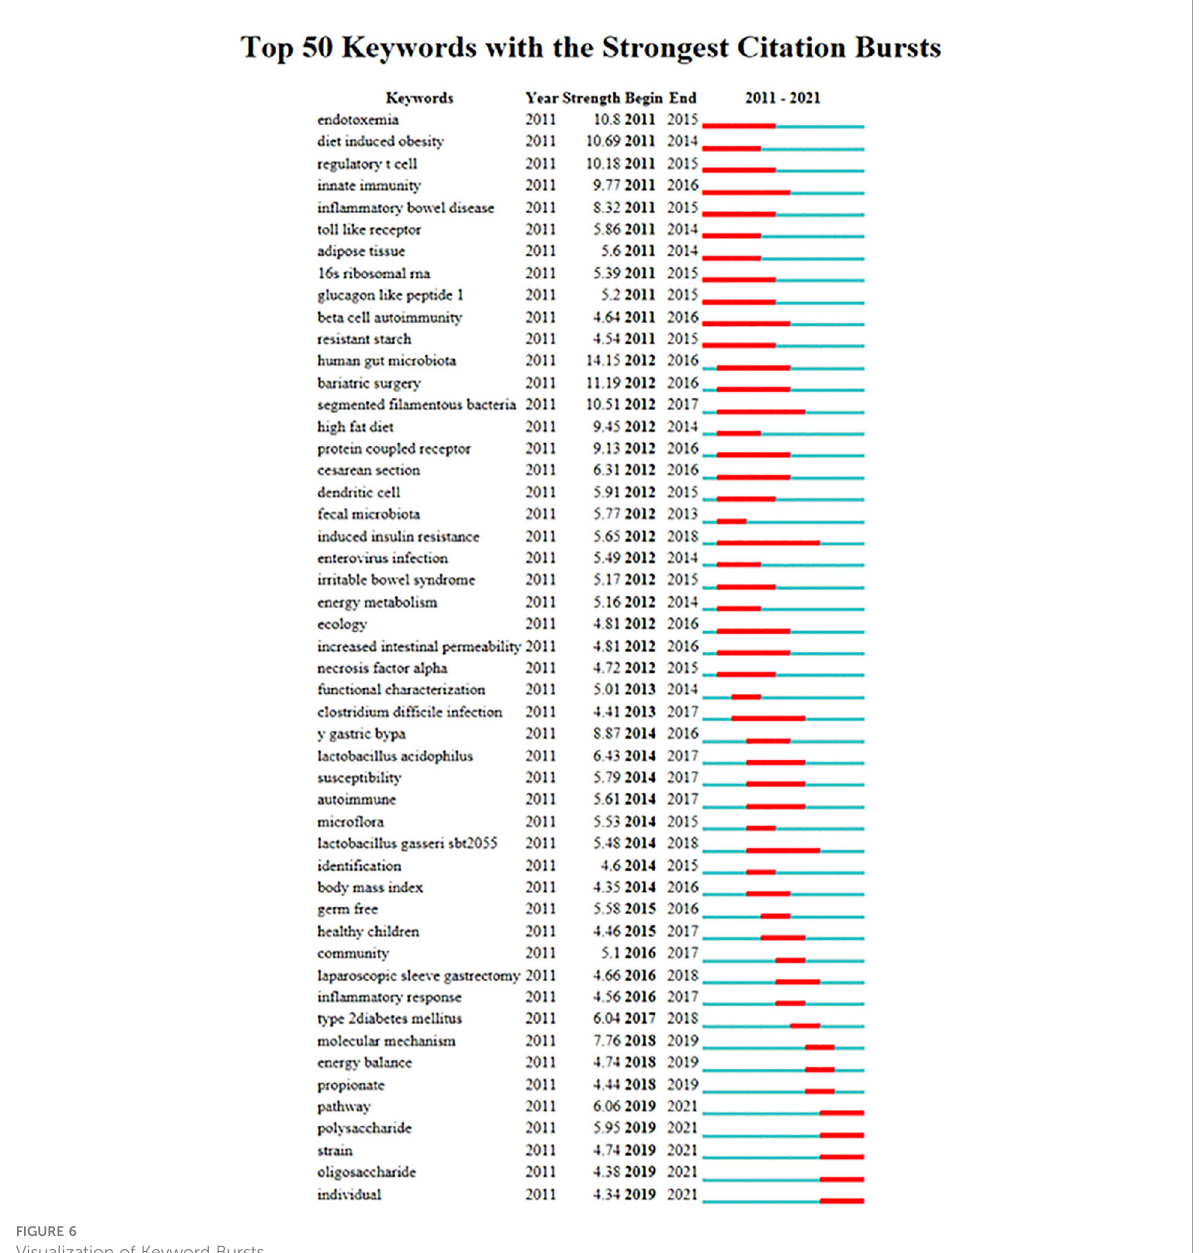
FIGURE 6 Visualization of Keyword